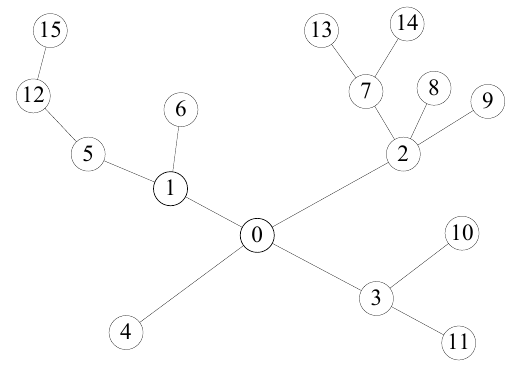
Figure 14. Topology for the WSN testbed